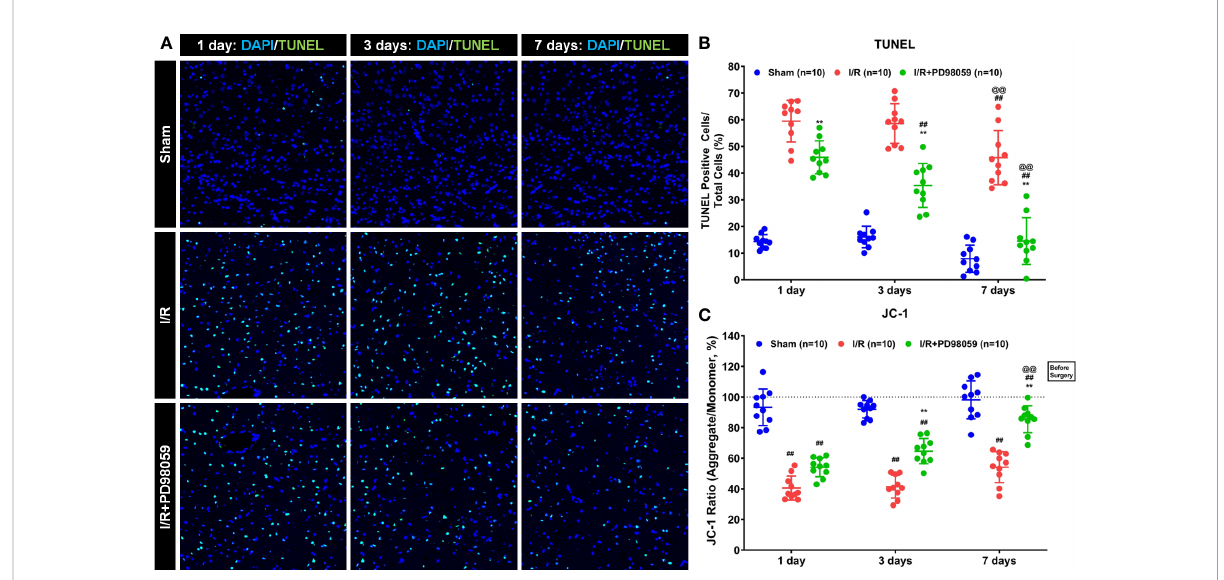
FIGURE 2 Effects of PD98059 on brain mitochondrial potential and apoptosis in diabetic rats. After I/R injury in diabetic rats, 10 diabetic rats were treated with mock or PD98059, respectively. Ten sham-operated (Sham) rats were used as the control group. The number of cell apoptosis and membrane mitochondrial potential were determined using TUNEL assay (A, B) and JC-1 analysis (C) were determined after treatment on the 1 st , 3 rd , and 7 th day. Each set of data is Mean ± SD, n = 10, compared with I/R, **p < 0.01; Compared with I/R group treated for 1 day, ## p < 0.01; Compared with I/R group treated for 3 days, @@ p <